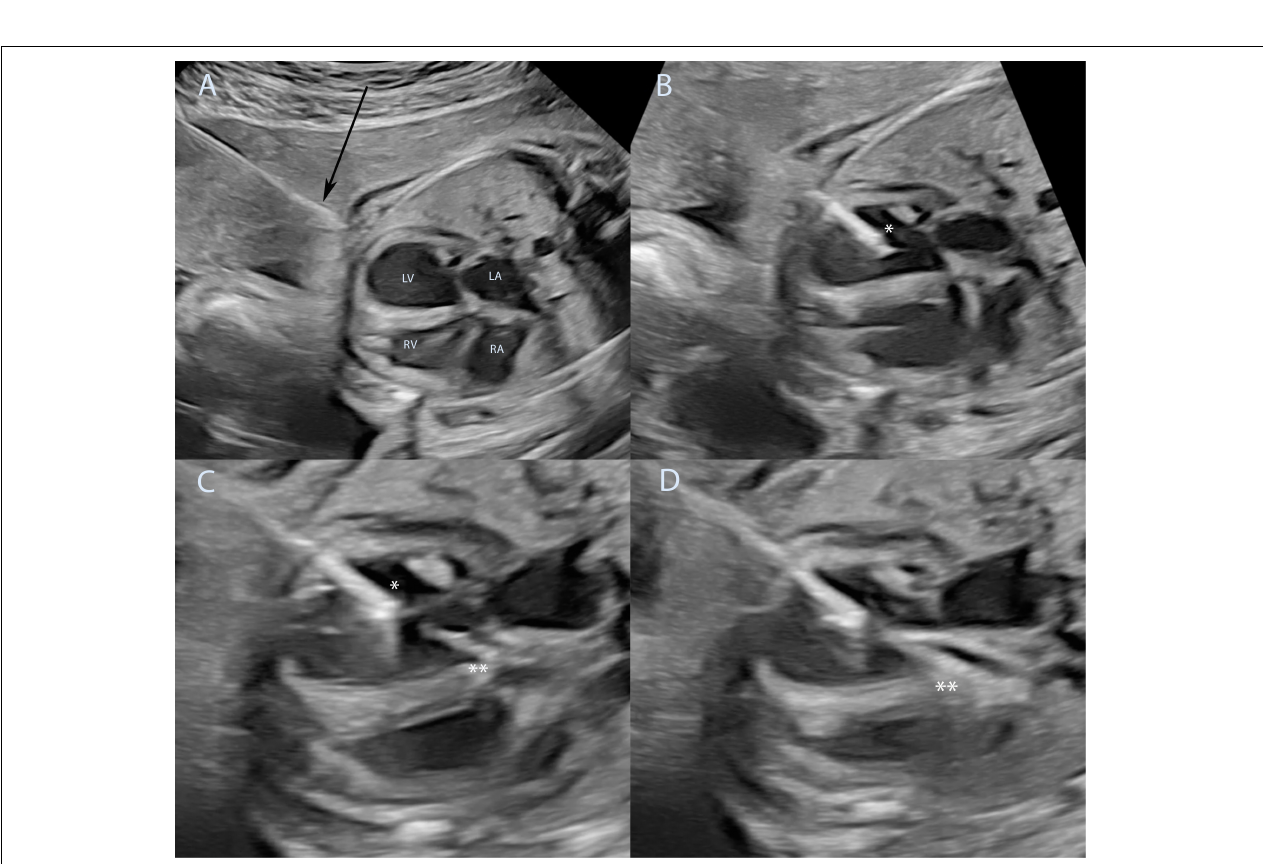
FIGURE 4 | Technique of fetal aortic valvuloplasty performed under ultrasound guidance. Fetal aortic valvuloplasty of a fetus at 25 weeks of gestation with critical aortic stenosis and eHLHS is shown. In panel (A) the ultrasound guided puncture of the fetal thoracic wall is shown, the arrow marks the needle just before entering the fetus. The needle has been introduced into the left ventricle (B) , asterisk marks the needle tip inside the left ventricle. The guidewire and the balloon catheter have crossed the aortic valve in panel (C) and the needle is slightly retracted to allow good positioning of the balloon just before dilation of the aortic valve ( ∗∗ ). Panel (D) shows full insufflation of the balloon catheter ( ∗∗ ). eHLHS, evolving hypoplastic left heart syndrome; LA, left atrium; LV, left ventricle; RA, right atrium; RV, right